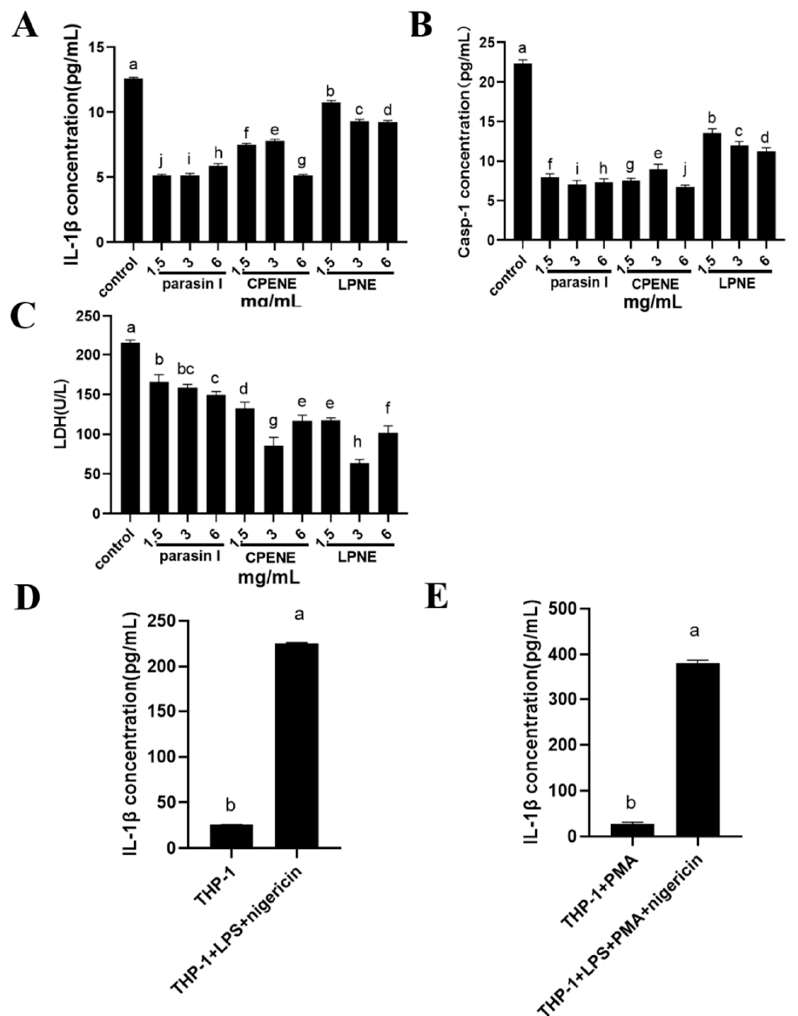
Figure 3. The Pickering emulsion enhances the inhibition effect of Parasin I on activated NLRP3 inflammasome in RAW 264.7. The IL-1 β ( A ), casp-1 ( B ) and LDH ( C ) concentration in RAW 264.7, and the induction of THP-1 with PMA ( D ) or without PMA ( E ). different letters (“a”–”j”) indicate significant differences ( p < 0.05).